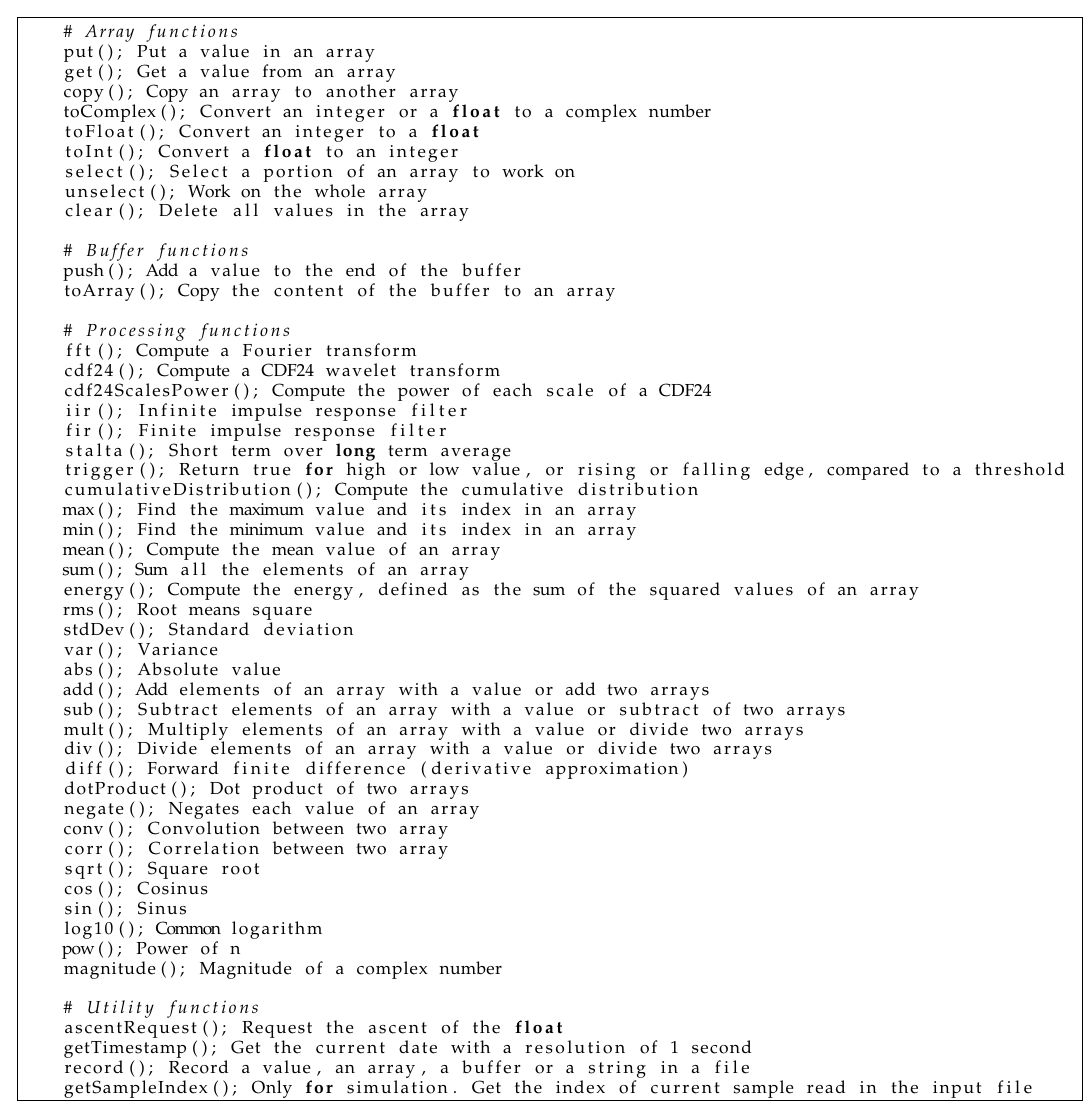
Table A2. List of functions available in the current version of